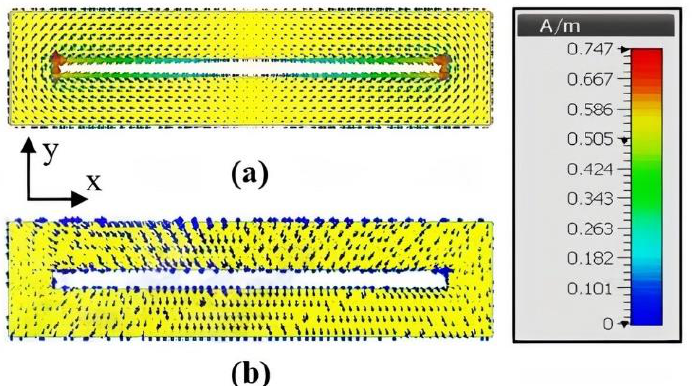
Figure 6. Surface current distribution of the loop scatterer at resonant frequency 3.05 GHz: ( a ) Scatterer is in untouched state; ( b ) finger is in contact with the scatterer.